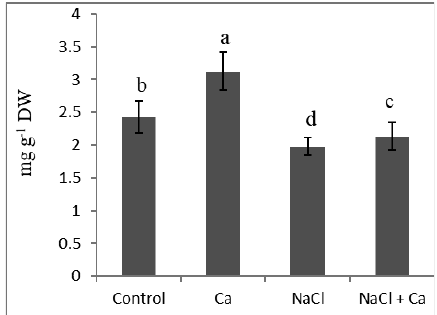
Fig. 7: Effect of salinity stress (100 mM NaCl) on content of total phenols in soybean ( Glycine max L.) with and without calcium supplementa‑ tion. Data is mean (±SE) of three replicates and bars with different letters denote significant difference at P ≤